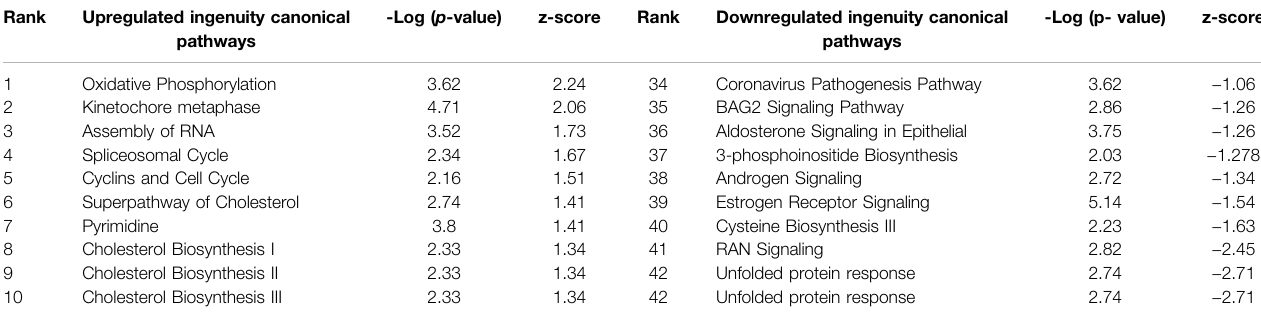
TABLE 3 | Ingenuity Pathway Analysis table of Canonical Pathways from CPxCB DEGs ( p < 0.01, log fold change > 1/ < -1). Redundant pathways, pathways with no z-score or z-score between -1 and one removed. Mapped: 2374; unmapped: 594.1,465 analysis-ready molecules: 735 upregulated and 730 downregulated. Ranked by z-score. Left: upregulated pathways. Right: Downregulated pathways. Ranked by z-score. Rank Upregulated ingenuity canonical